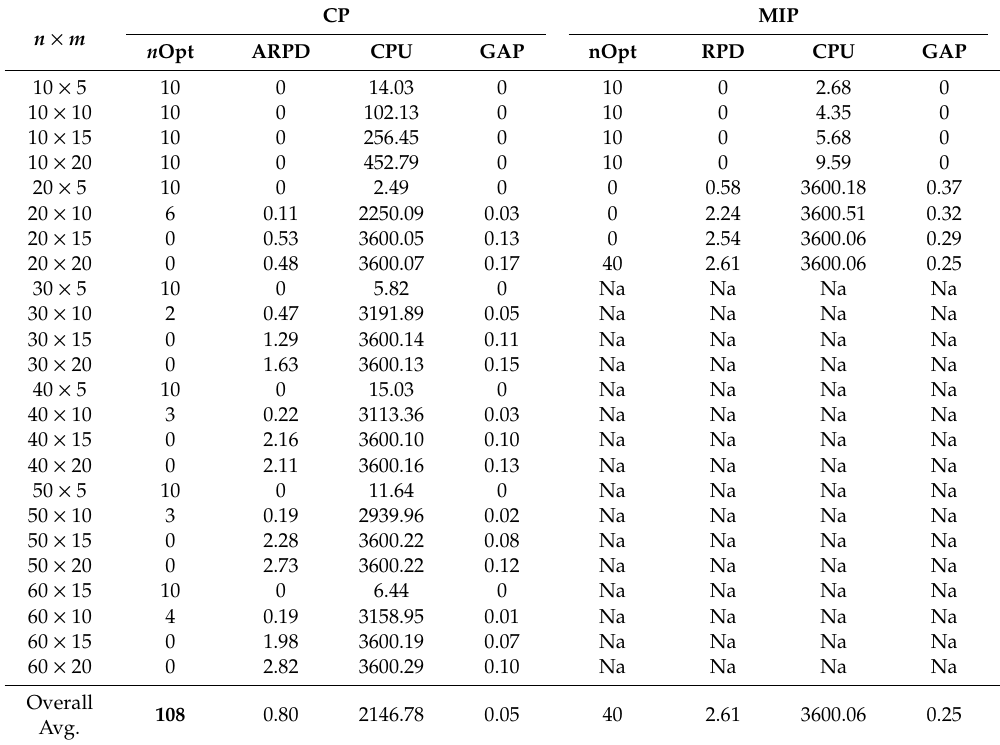
Table 3. MIP and CP results for VRF small benchmarks with 3600 s time limit (The number in bold shows the total optimal